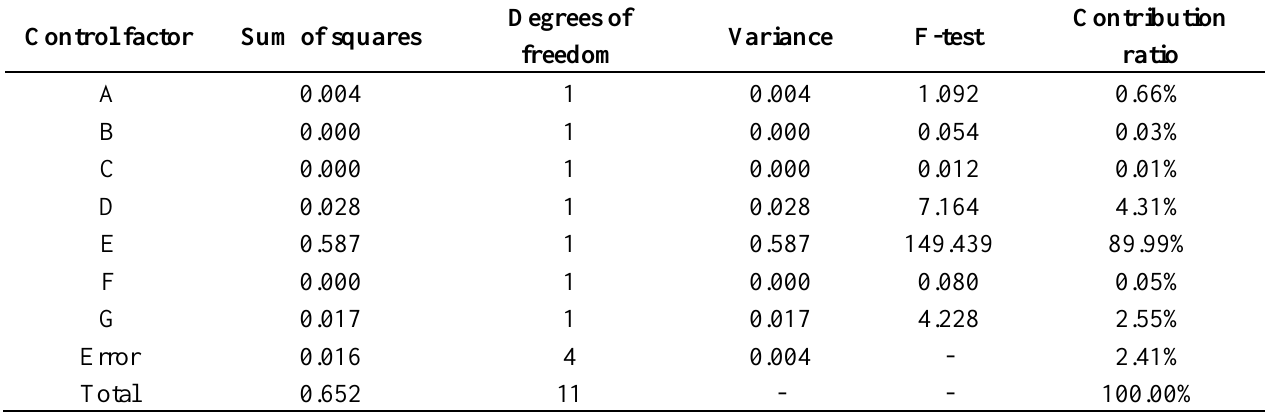
Table 8. Results of ANOVA for weighted Grey-Taguchi